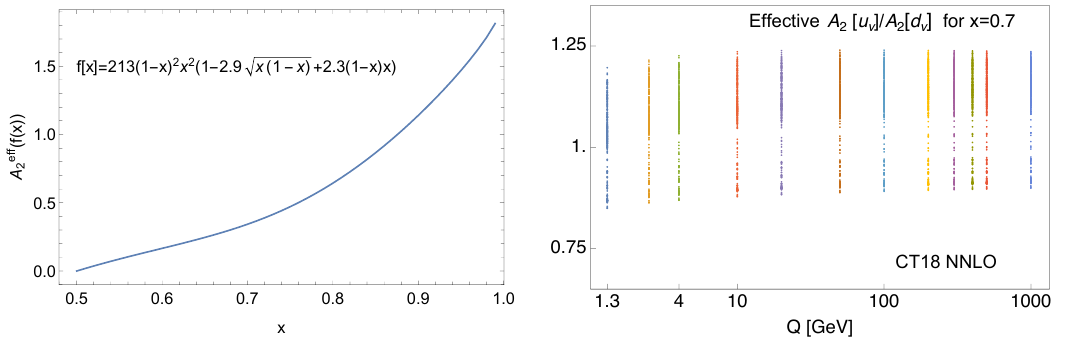
( x ) for a toy pion parametrization f ( x ) ∝ ( 1 − x ) A 2 2 [ u ] / A eff [ d ] for CT18NNLO valence PDFs at x = 0.7 V V 2 2